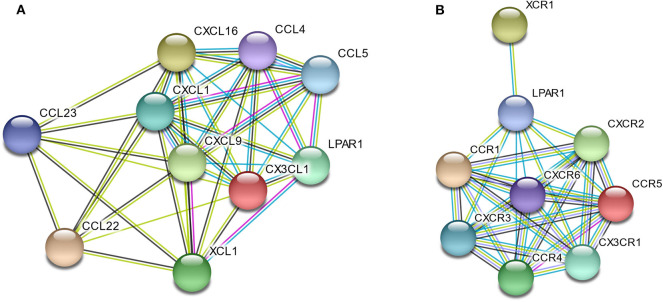
Protein–protein interactions (PPI) network based on lysophosphatidic acid receptor 1 (LPAR1) and chemokines/chemokine receptors with a minimum required interaction score > 0.40. (A) PPI network among LPAR1 and nine chemokines. (B) PPI network among LPAR1 and eight chemokine receptors.